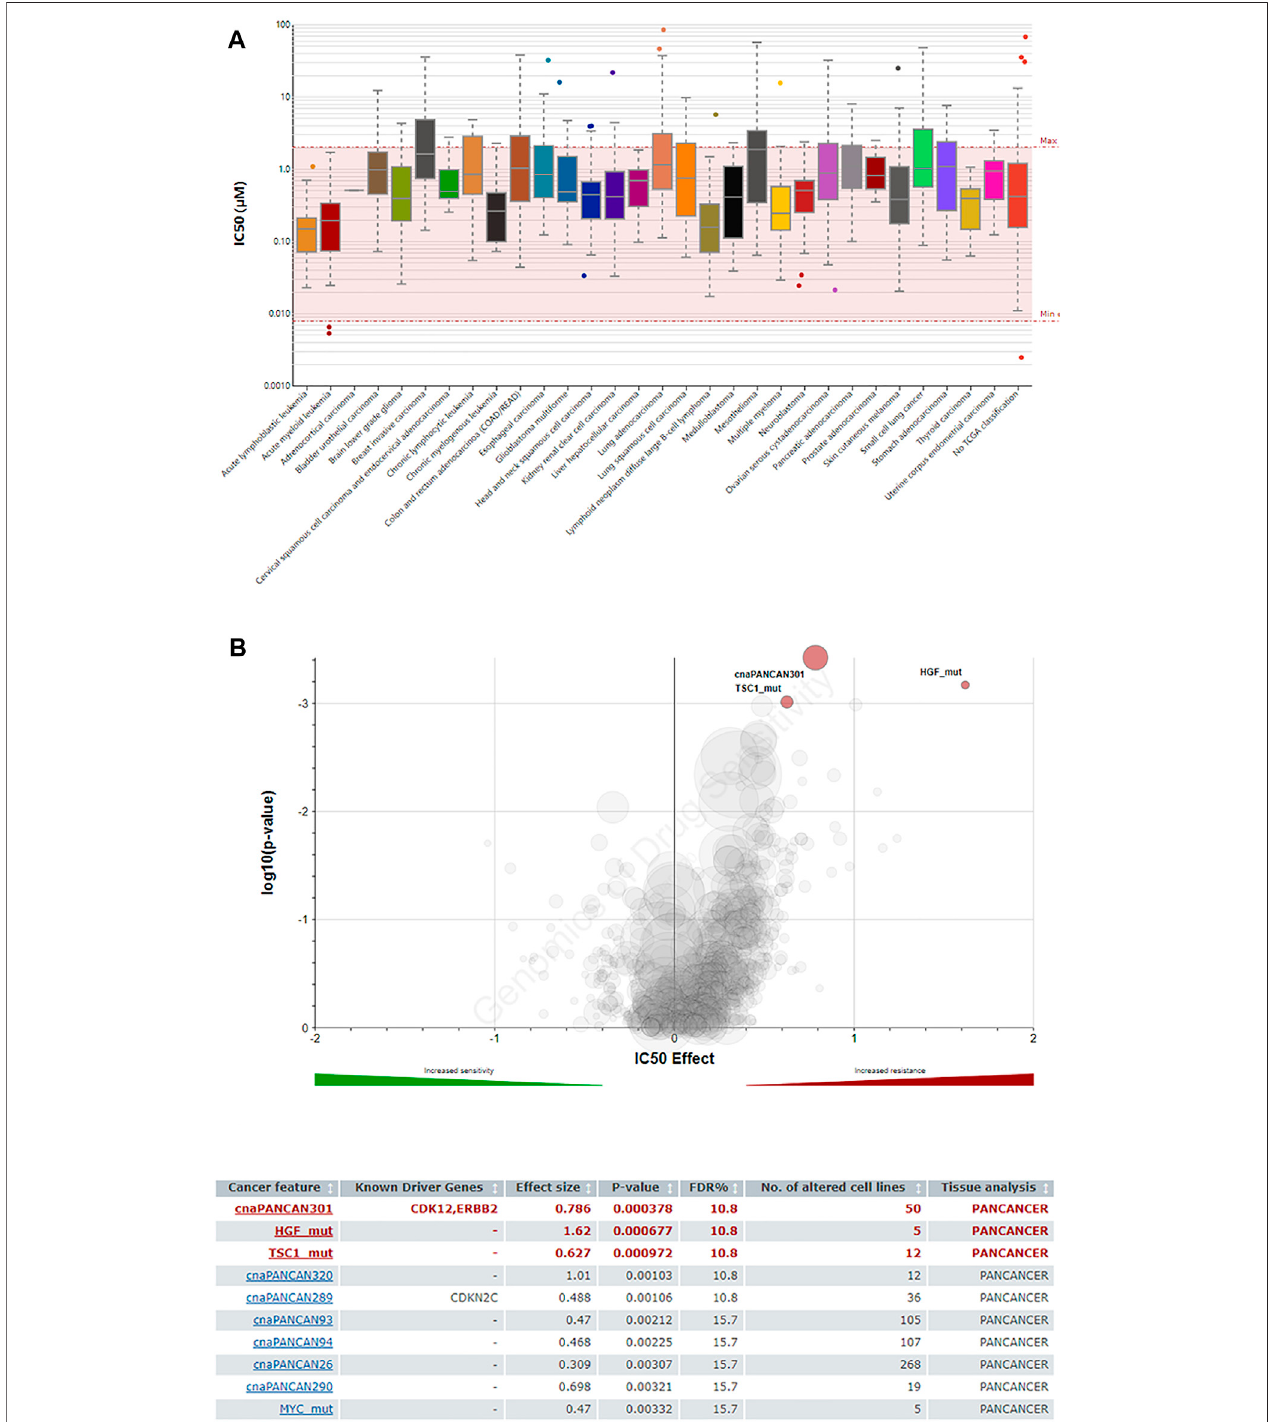
FIGURE 5 | Predictive effects of the JAK2 inhibitor lestaurtinib on cancer cells (GDSC). (A) IC 50 distribution of lestaurtinib by tissue type. (B) Volcano plot of the sensitivity of cancer cell lines to lestaurtinib.